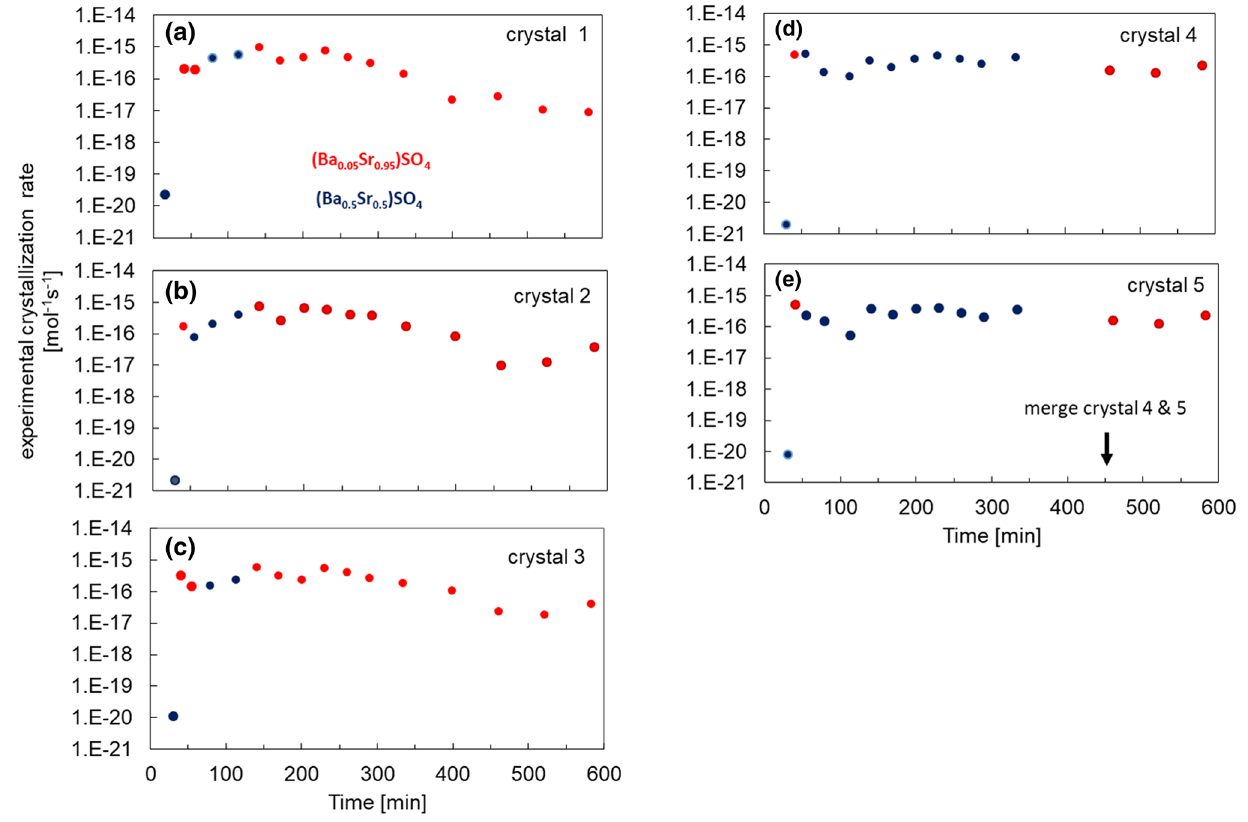
Figure 4. ( a – e ) experimentally derived crystallization rates of crystals 1–5 in reaction chamber 4.